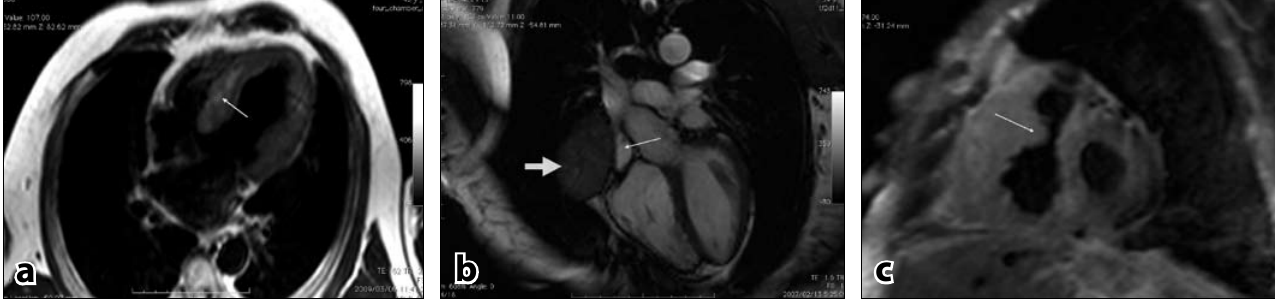
Fig. 1a. Four-chamber T2-weighted image showing evidence of active inflammation (arrow) in a patient with myocarditis. (1b.) Four-chamber bright-blood image showing a mediastinal neoplasm, post-operatively confirmed to be a benign thymoma (block arrow) impressing the right atrium (arrow) but not invading the heart. (1c.) Short axis post-contrast T1 image showing diffuse RV infiltration, confirmed on catheter directed myocardial biopsy to represent primary cardiac lymphoma, bulging into and severely narrowing the RV outflow tract (arrow).